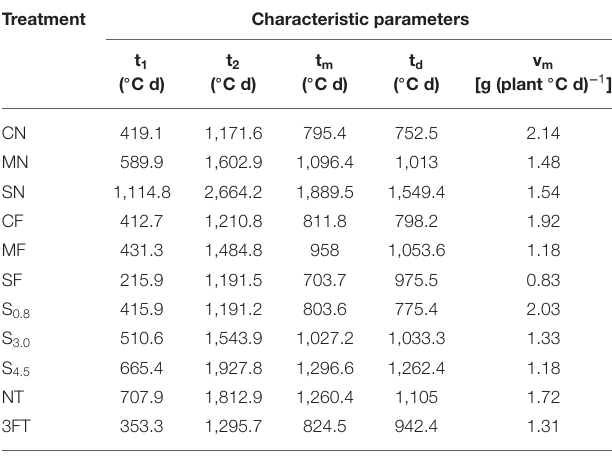
TABLE 7 | Characteristic parameters calculated by logistic equation for biomass accumulation among the treatments.